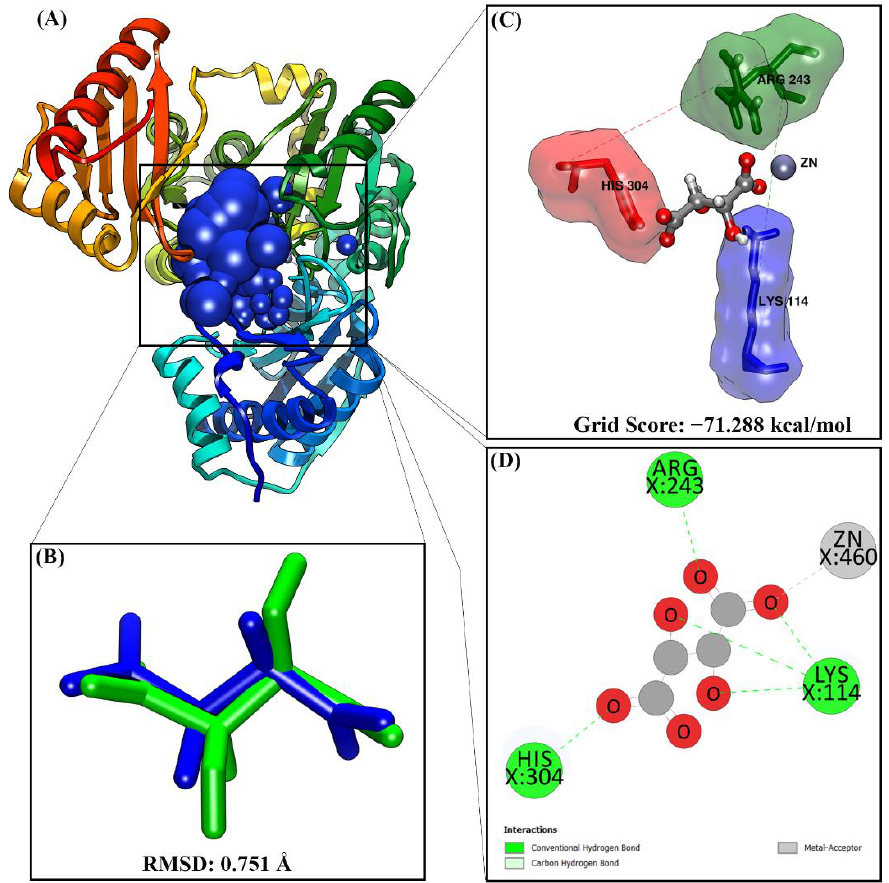
Figure 1. Determination of the receptor’s active site: ( A ) selection of a cluster sphere with a radius of 10.0 Å using the TLA coordinates; ( B ) the superposition of native ligands between the crystal (blue) and pose (green); ( C ) interaction between ligands (pose) and amino acid residues on the receptor’s active site; ( D ) type of interaction shown in the two-dimensional diagram.